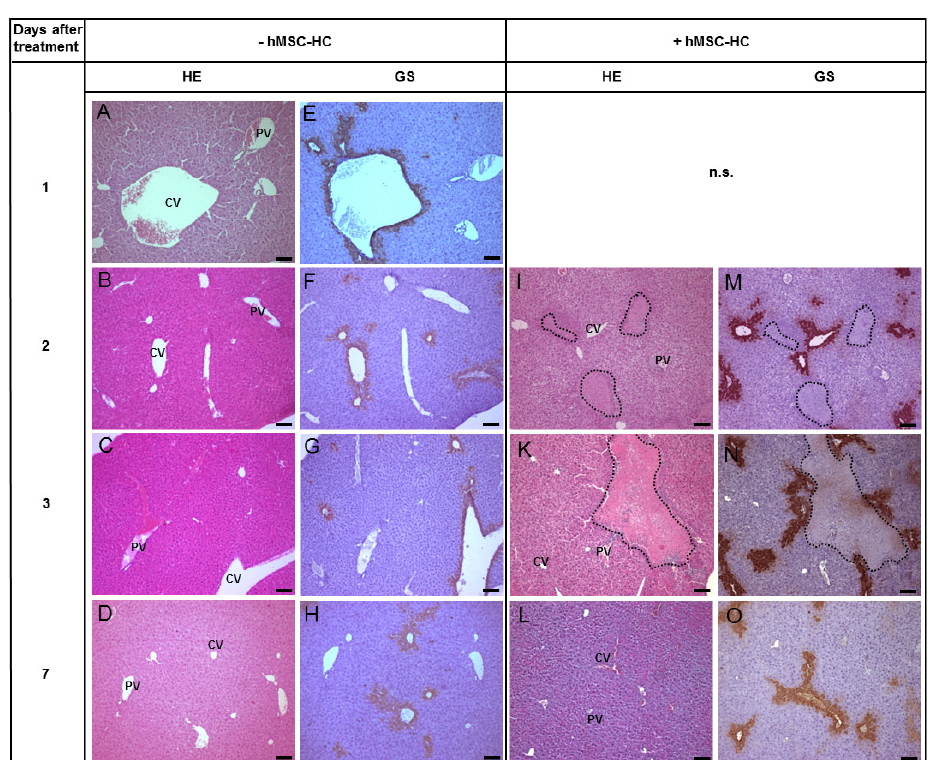
Figure 2. Periportal localisation of transplanted hMSC-HC in livers of mice without APAP treatment. Mice were injected PBS as a control. One day later (=1 day after